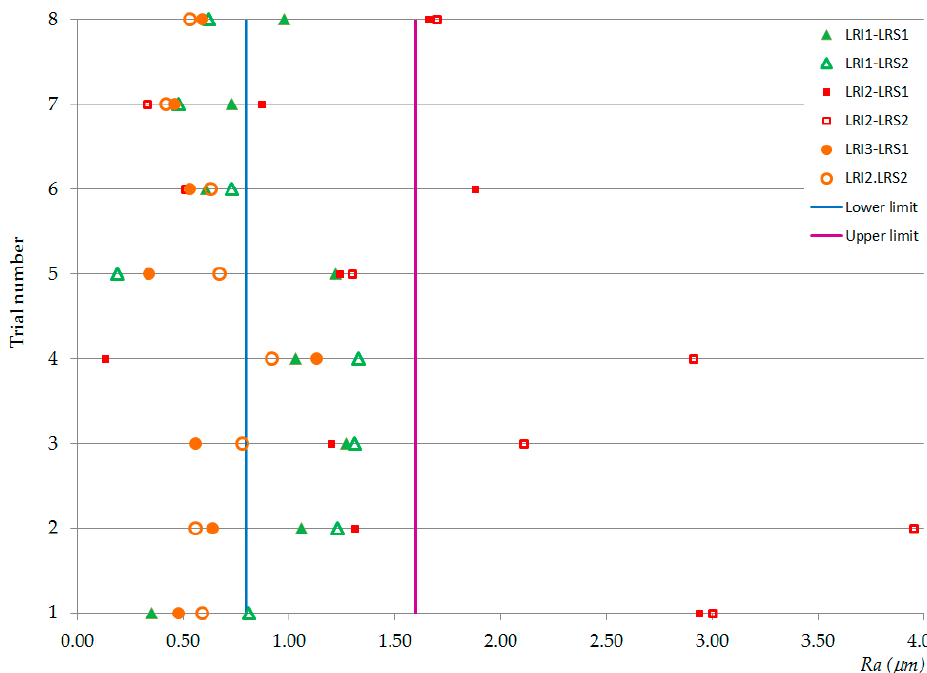
Materials 2020 , 13 , x FOR PEER REVIEW Figure 6. Graphic representation of the Ra values. Figure 6. Graphic representation of the Ra values.